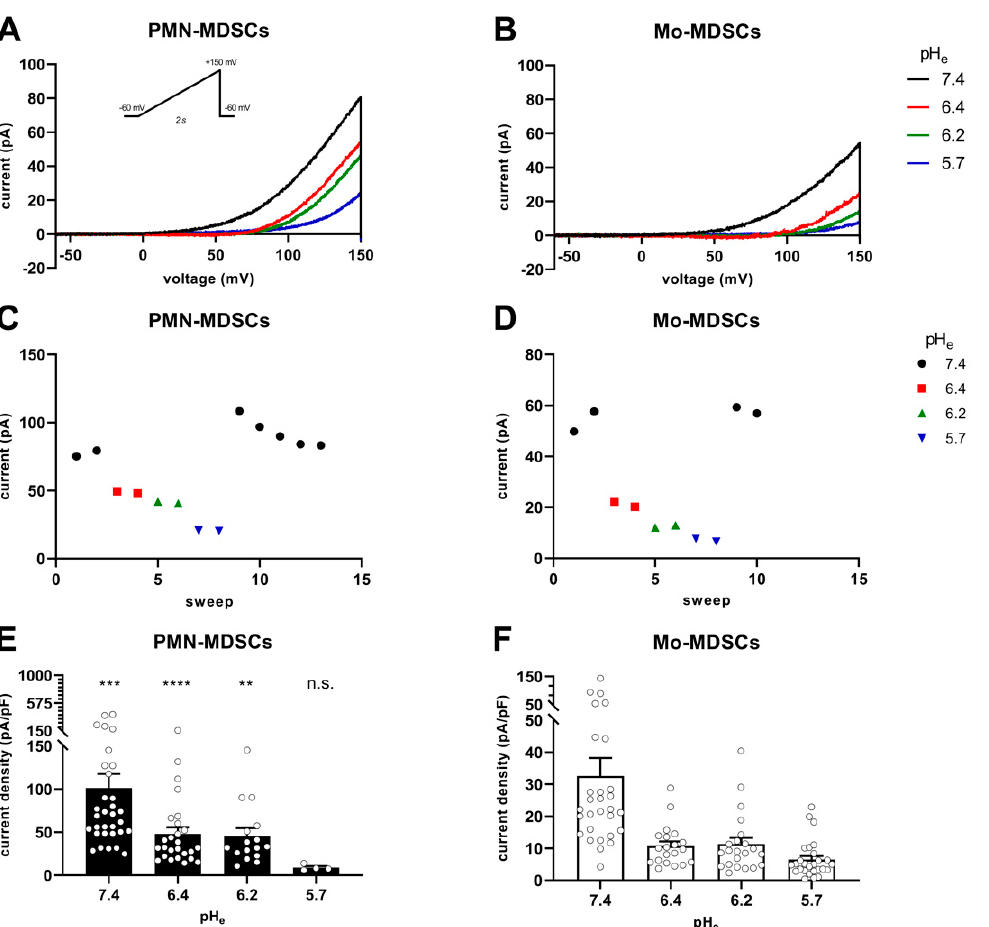
Figure 7. pH e -induced shift of Hv1 currents in murine PMN- and Mo-MDSCs. ( A – D ) Representative whole-cell current traces evoked by voltage ramps ranging from − 60 to +150 mV, lasting 2 s and repeated every 15 s (see inset) in a PMN- ( A ) and a Mo-MDSC ( B ) freshly isolated from murine LLC. The currents at +145 mV were determined for every trace (see Materials and Methods) and plotted as a function of the sweep number. Currents obtained at different pH e values for PMN- ( C ) and Mo-MDSCs ( D ) are represented by different colors and symbols (black circle: pH e 7.4; red square: 6.4; green up triangle: 6.2; blue down triangle: 5.7). ( E , F ) Current density was calculated as the ratio of